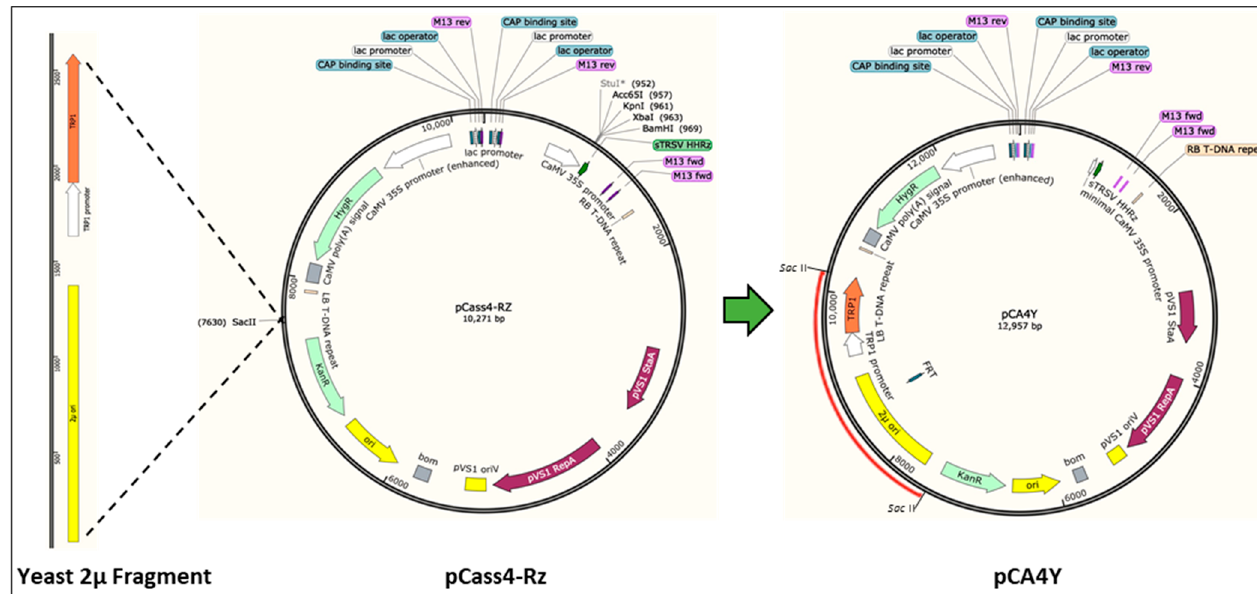
Figure 1. Schematic representation of the construction flows of the yeast– E. coli – Agrobacterium shuttle vector pCA4Y. Briefly, we amplified the yeast 2 μ replication origin and the tryptophan (TRP1) autotrophic marker gene fragment from the commercial pGBKT7 plasmid (Accession No. LT726927.1) and inserted the Sac II site of the binary vector pCass4-Rz.